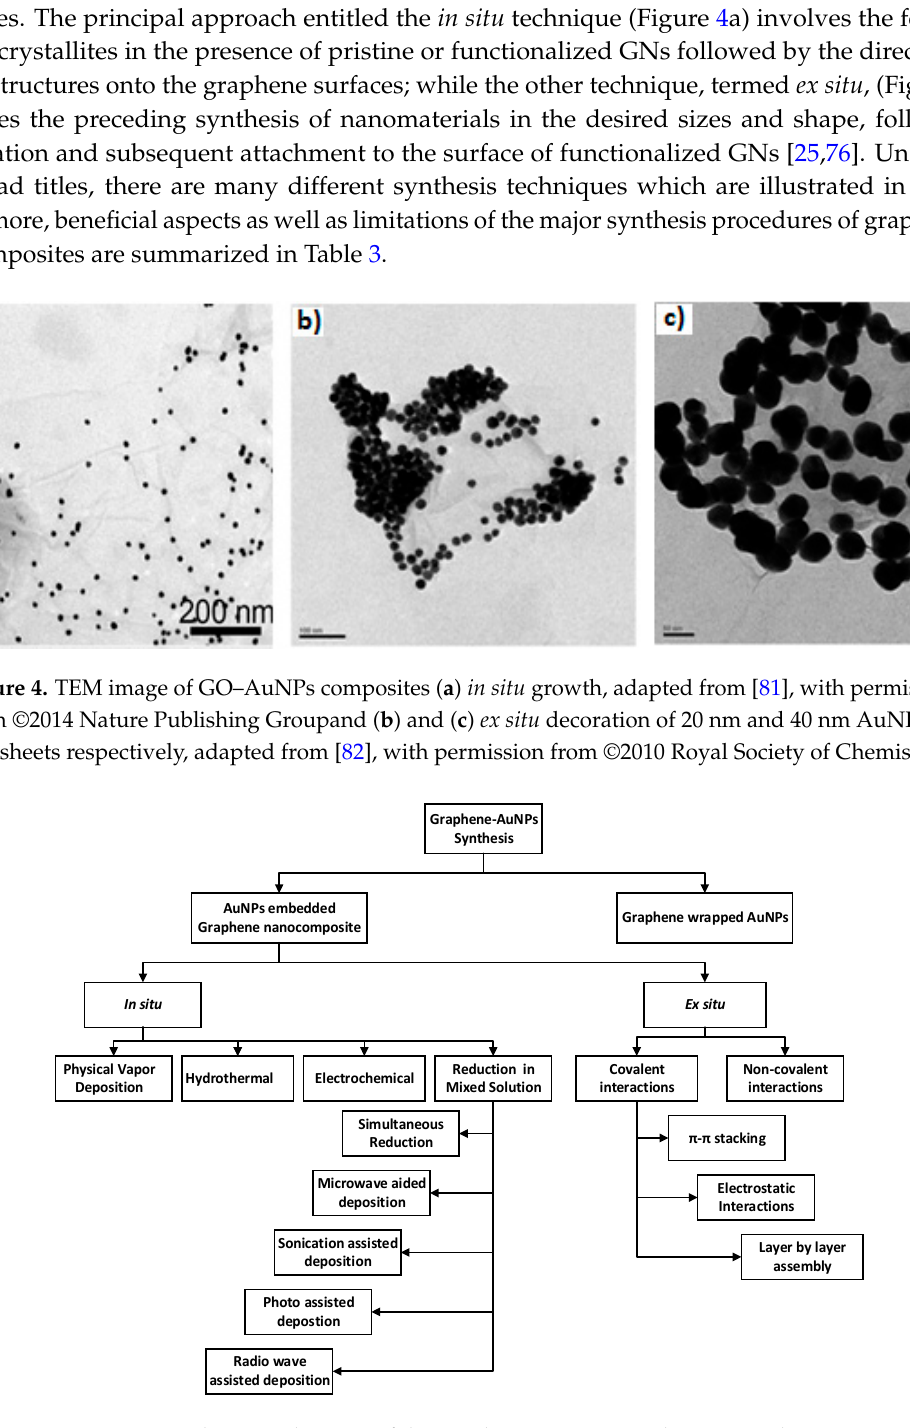
Figure 5. Schematic diagram of the graphene–AuNPs synthesis procedures.